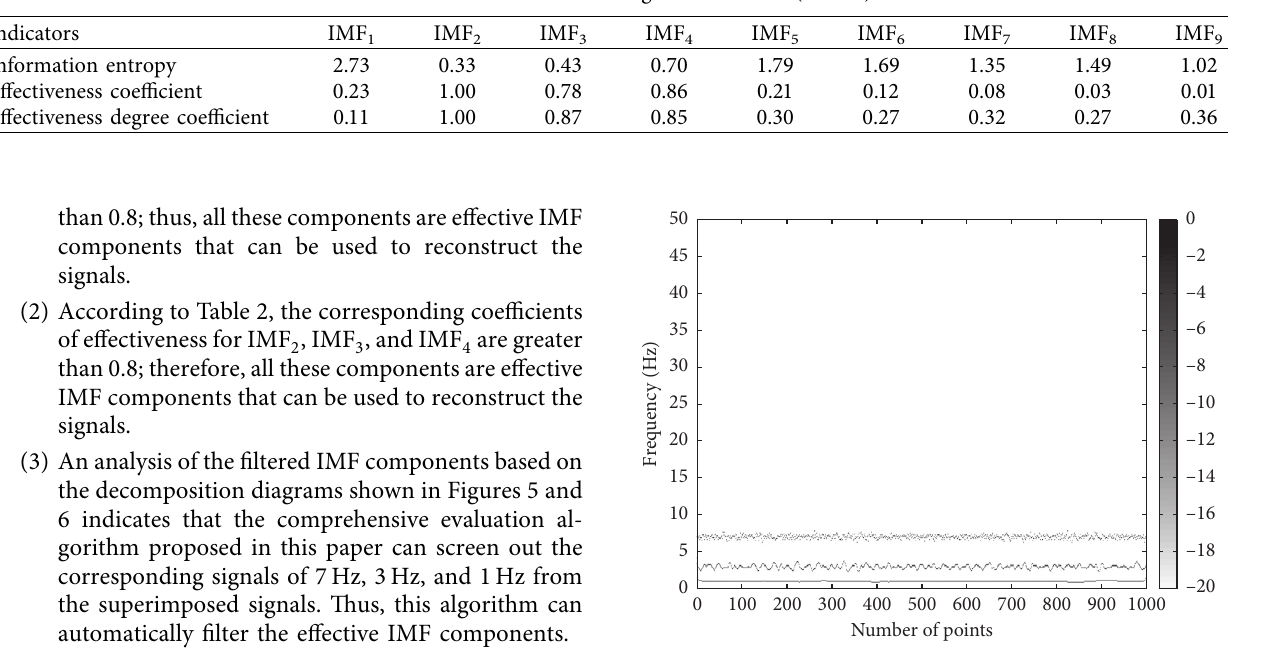
Table 2: Table of effectiveness degree coefficients (EEMD).